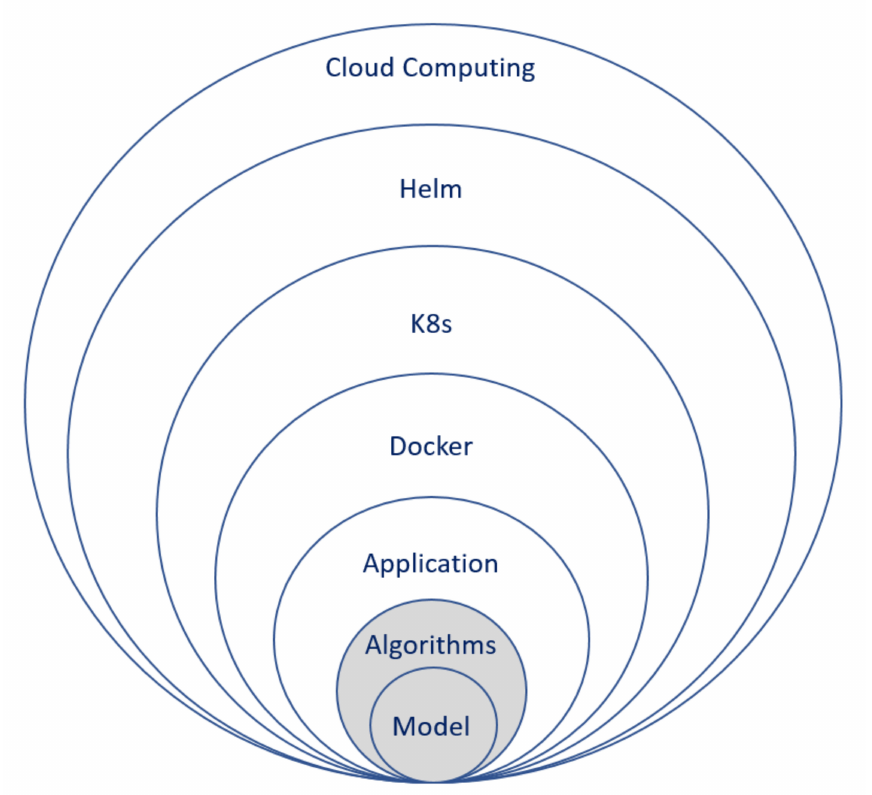
Figure 2. The different layers in the EDSS as a service design. Note: Grey represents layers that will require changes between implementations of the EDSS. White represents the infrastructure layers that do not require changes between different